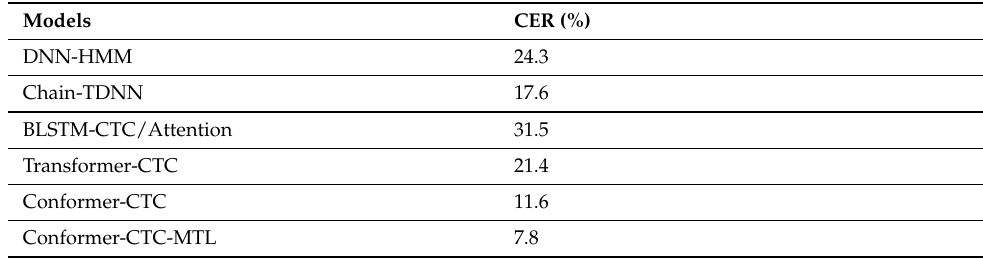
Table 4. SOTA results tested on THUYG-20